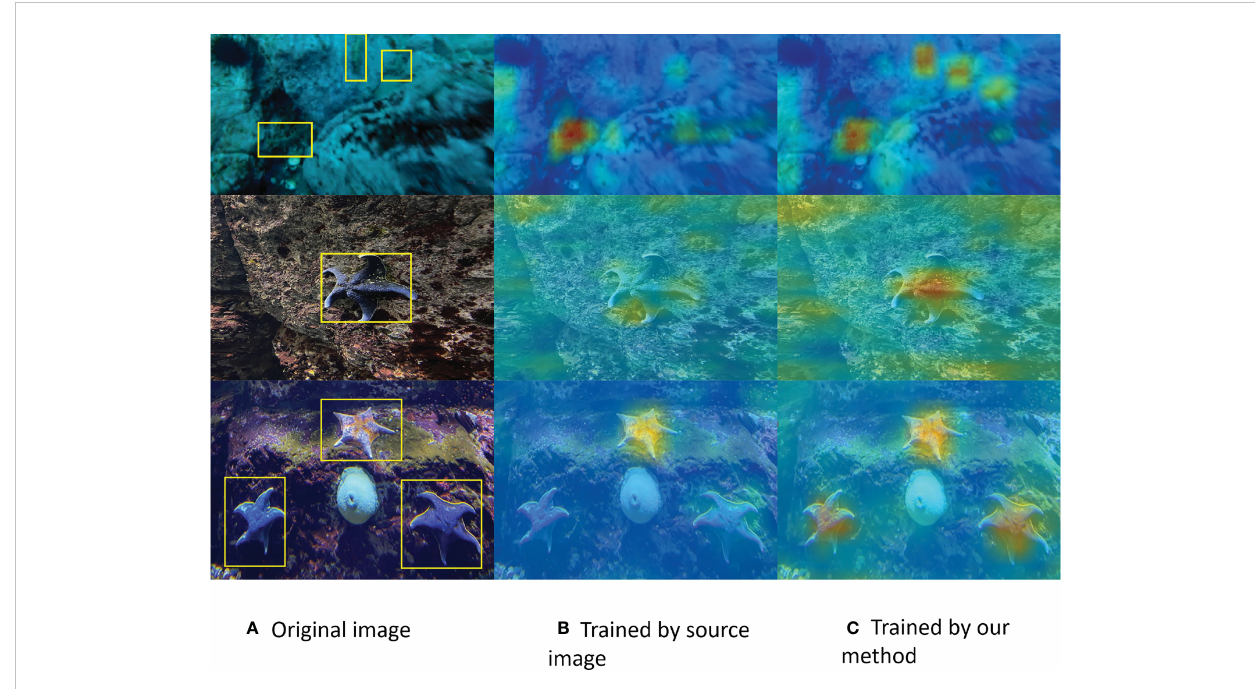
FIGURE 7 Our Grad-CAM images under different